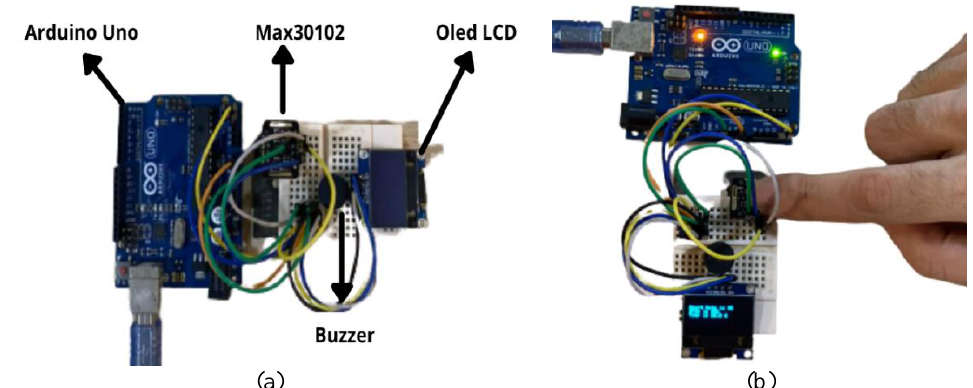
Figure 3. Prototype of project: (a) labelled prototype, and (b) results obtained through